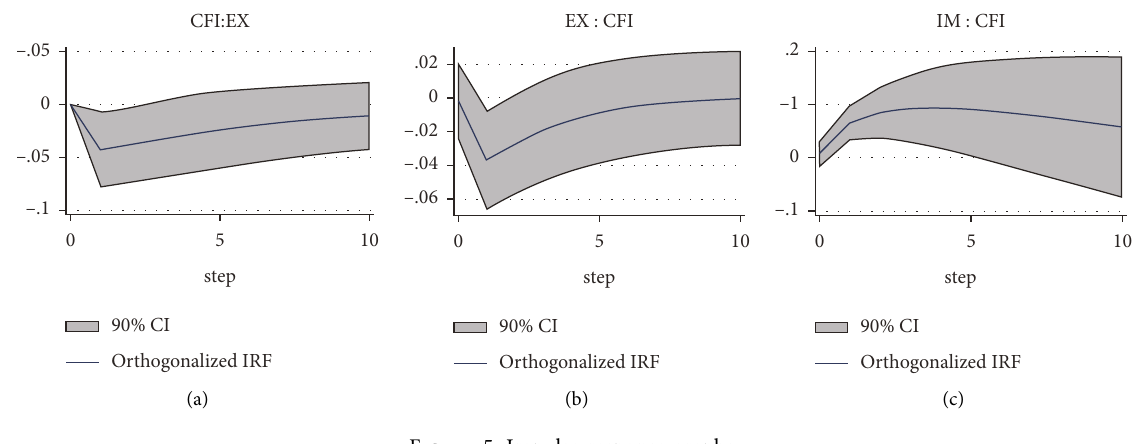
Figure 5: Impulse response